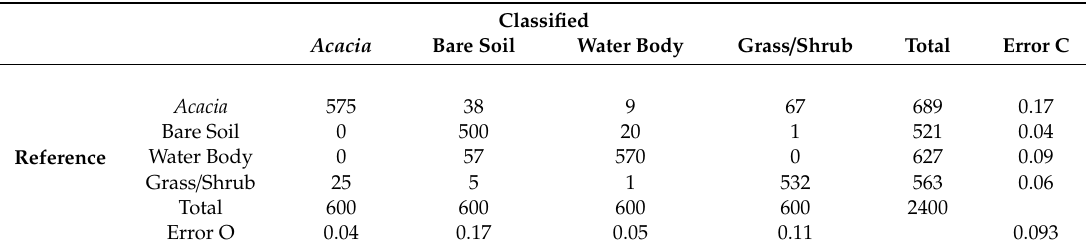
Table 1. Accuracy assessment and the error matrix of the generated LULC map. Error C is the error of commission, and Error O is the error of omission. The overall accuracy of the categorical map results is 90.7%.